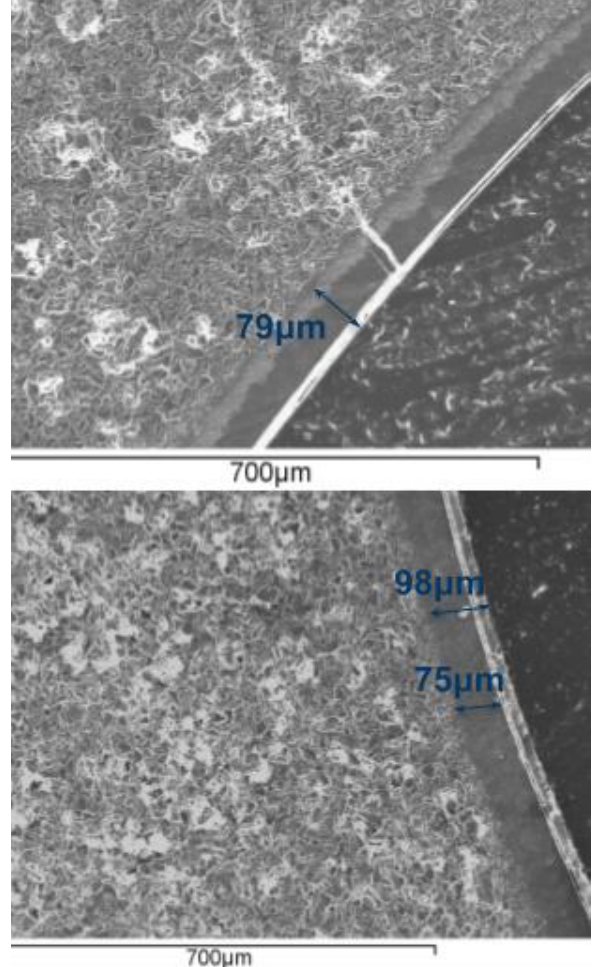
Figure 2. Scanning Electron Microscopy (SEM) image of silicone–ceramic membranes: ( top ) single- layer membrane; ( bottom ) double-layer membrane.